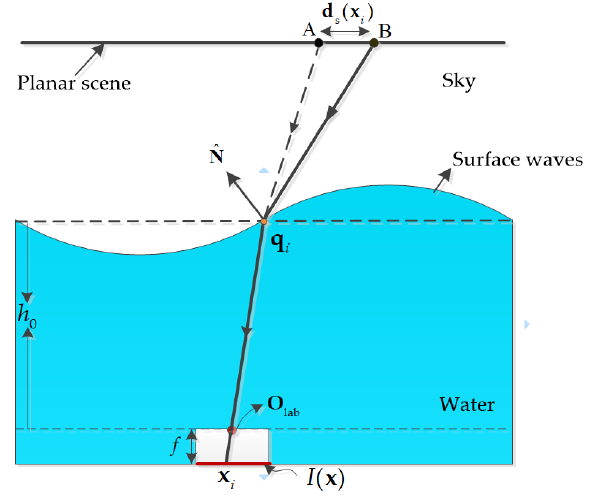
Figure 3. Illustration of refractive distortion.